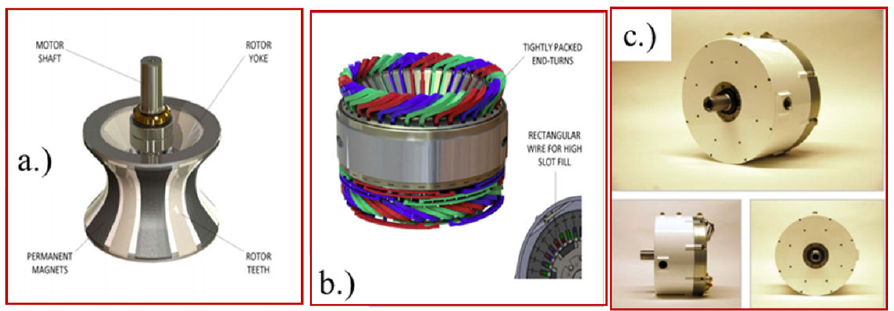
Figure 8. Hybrid-field Traction Motor ( a ) rotor ( b ) stator with integrated cooling ( c ) Partially assem- bled motor